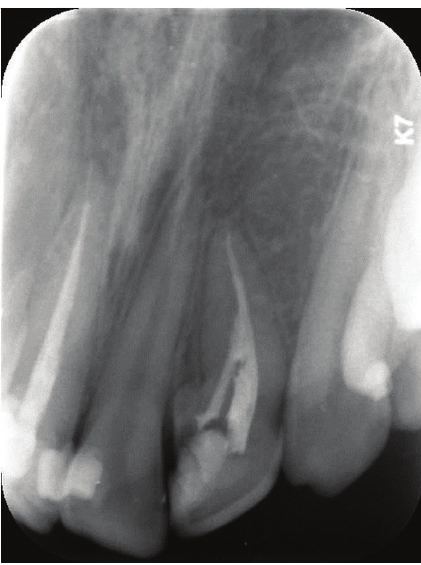
Figure 4: Recall radiograph after 6